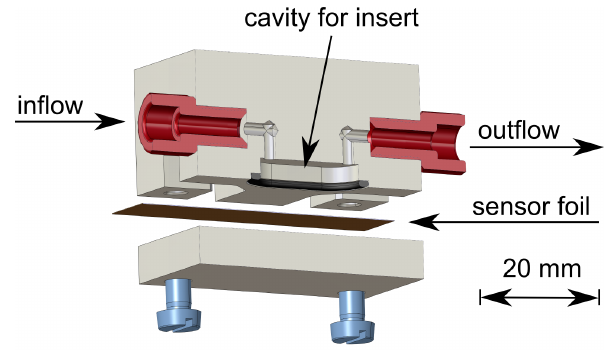
Figure 7. 3-D cross-sectional view of the measurement chamber used (according to Schmitt et al.,